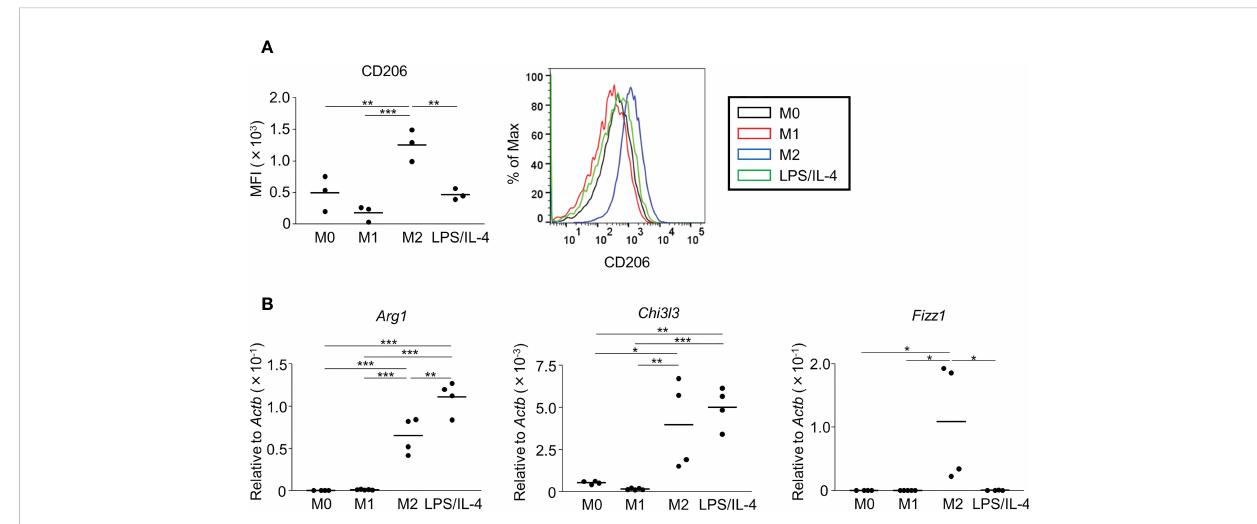
FIGURE 2 M2 marker expression pro fi les of M2 macrophages and LPS/IL-4-induced macrophages. Bone marrow-derived macrophages were prepared and stimulated with either LPS, IL-4, or LPS plus IL-4 for 24 h (A, B) . (A) Flow cytometric analysis was performed to examine the expression of the M2 marker CD206. Mean fl uorescence intensity and representative histogram data are shown gated on 7-AAD − CD45 + CD11b + F4/80 + for CD206. (B) Gene expression levels were examined by reverse transcription-quantitative PCR analysis. The expression levels of Arg1 , Chi3l3 , and Fizz1 were normalized to that of Actb . Each point represents the data from an individual experiment. Horizontal bars indicate mean value. * P <0.05, ** P <0.01, *** P